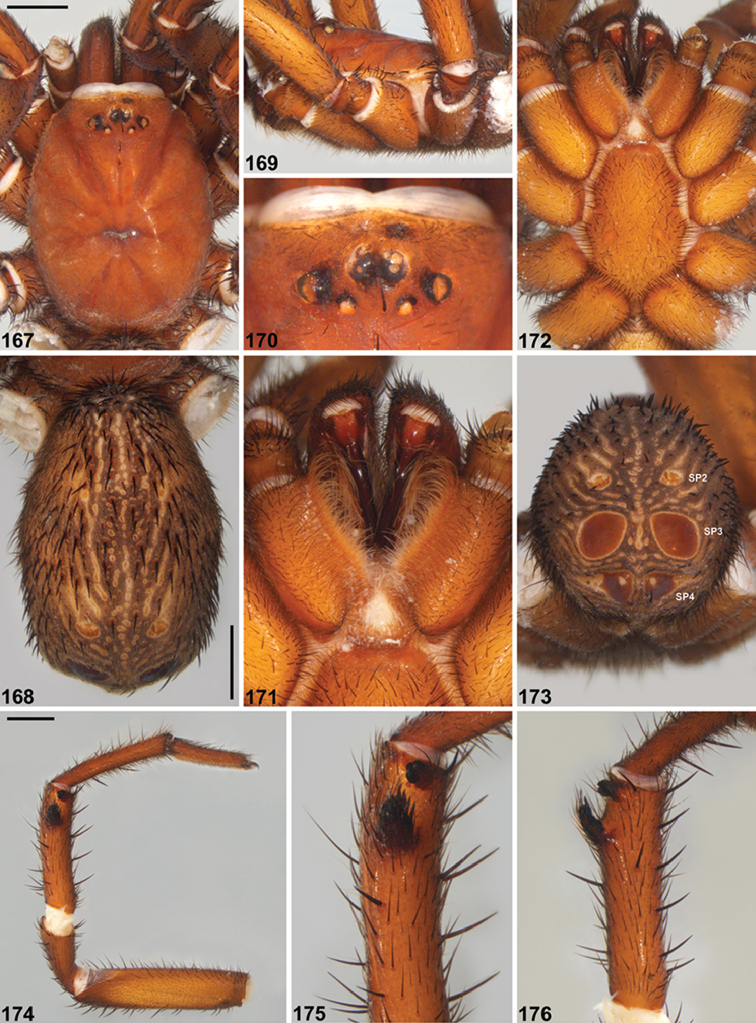

Idiosoma
gardneri sp. n., male holotype (WAM T139528) from Lesueur National Park (Western Australia; GES), somatic morphology. 167–168 Carapace and abdomen, dorsal view 169 Carapace, lateral view 170 Eyes, dorsal view 171 Mouthparts, ventral view 172 Sternum, ventral view 173 Abdomen, posterior view 174 Leg I, prolateral view 175 Leg I tibia, clasping spurs, prolateral view 176 Leg I tibia, proventral view. Scale bars 2.0. SP2–4 = sigilla pairs 2–4.